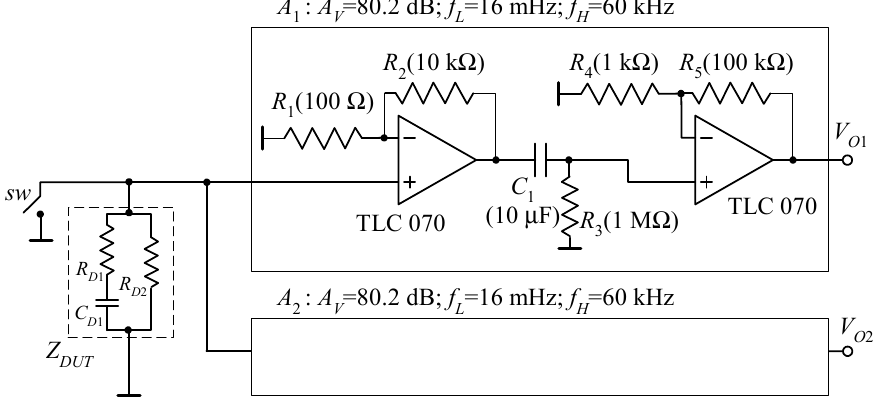
Figure 5. Dual channel amplifier used for experimentation. When the switch SW is closed, we can measure the background noise of the amplifier. With the switch open, Z DUT is used as a DUT for verifying the ability of the system to perform cross-correlation measurement in the entire frequency band of interest.